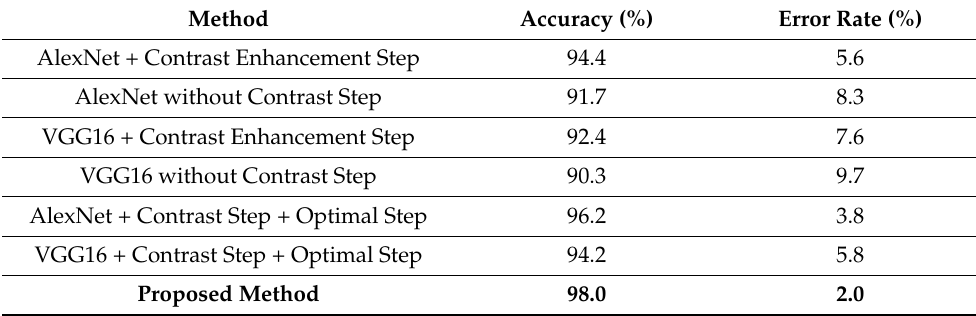
Table 4. Comparison of the proposed accuracy with different feature combinations and steps.